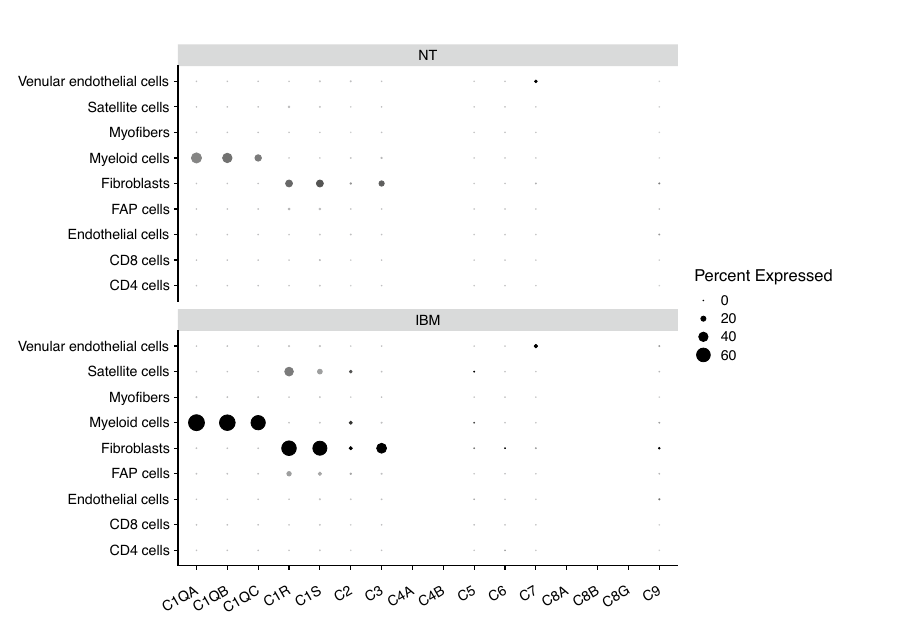
Figure 3. Single-cell RNA sequencing analysis of complement genes from fresh muscle tissue. Biopsies from 3 patients with suspected IBM and 3 healthy volunteers were included. C1QA, C1QB, and C1QC were expressed at the highest levels in CD14 + /CD68 + myeloid cells (i.e., macrophages) whereas genes encoding C1R, C1s, and C3 were primarily expressed in fibroblasts. Unlike in healthy muscle, IBM muscle biopsies showed expression of C1R, and C1S in satellite cells and, to a lesser degree, in FAP cells. NT, Normal tissue; IBM, Inclusion body myositis; FAP, Fibroadipogenic